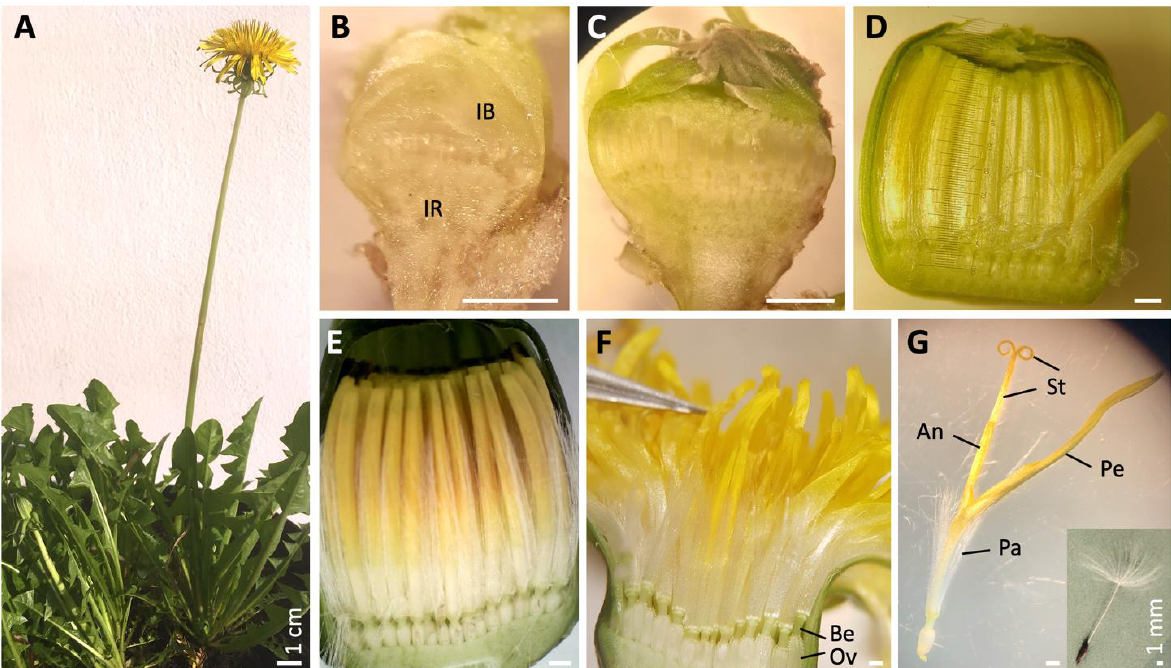
Figure 1. Dandelion plant and capitula at different developmental stages. ( A ) Mature Taraxacum officinale plant with one open capitulum ( stage 12 ) and one closed bud ( stage 10 ), showing the characteristic bare stems, leaf rosettes, and ligulate florets. ( B ) Bud of stage 2 (Table 1), with floral primordia formed. About the youngest harvestable bud (due to soft tissue, see right under). IR = inflorescence receptacle; IB = involucral bracts. ( C ) Bud of stage 7 ( stem ~0.2 cm), with all floral organs initiated, corolla lobs covering the top, organs elongating, and pappus length equalling half of the petal length. ( D ) Bud of stage 9 (stem ~1 cm), showing the elongated upper floral parts, with pigmentation of petals initiated. ( E ) Bud of Stage 11 (stem ~7 cm), with the corolla still tubular, bud still closed, and the pigmentation of petals finalized. ( F ) Open flower at anthesis, stage 12 , with corollas forming ligules, pollen maturing, and style enlarging. Be = beak; Ov = ovary. ( G ) One mature floret, stage 13 , with stigma lobes open and receptive. Pa = pappus; Pe = petals, lower 1/3rd tubular, upper 2/3rd ligulate; An = anthers arranged in a ring; St = style and stigmas; insert: mature fruit ( Cypsela ), stage 16 , with a long beak and opened pappus. © Kitty Vijverberg (A, E, G, insert), Julia Mars (B – D, F), Niki Vorgia (G).